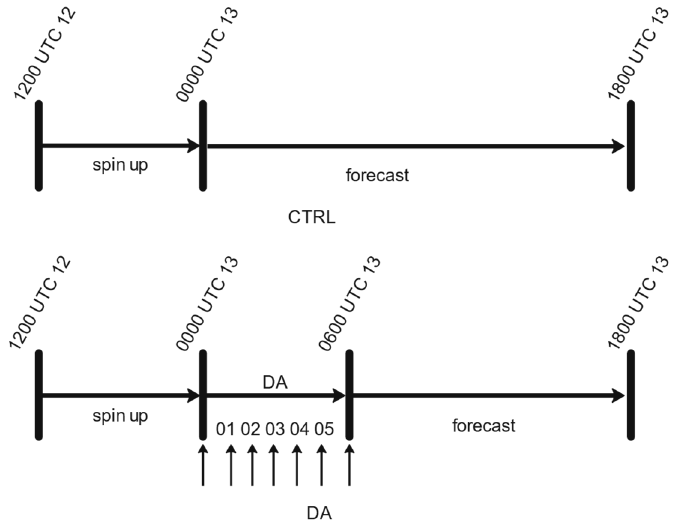
Figure 2. The flow chart for the control experiment (CTRL) and data assimilation experiments (DA).